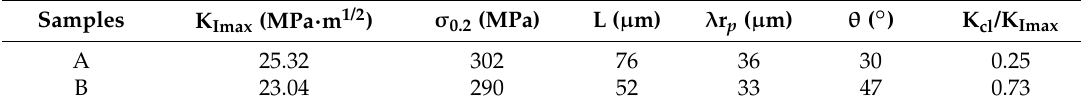
Figure 12. The distribution of L and θ for sample A ( a , b ) and sample B ( c , d ). Table 5. The theoretical results of crack closure level for samples A and